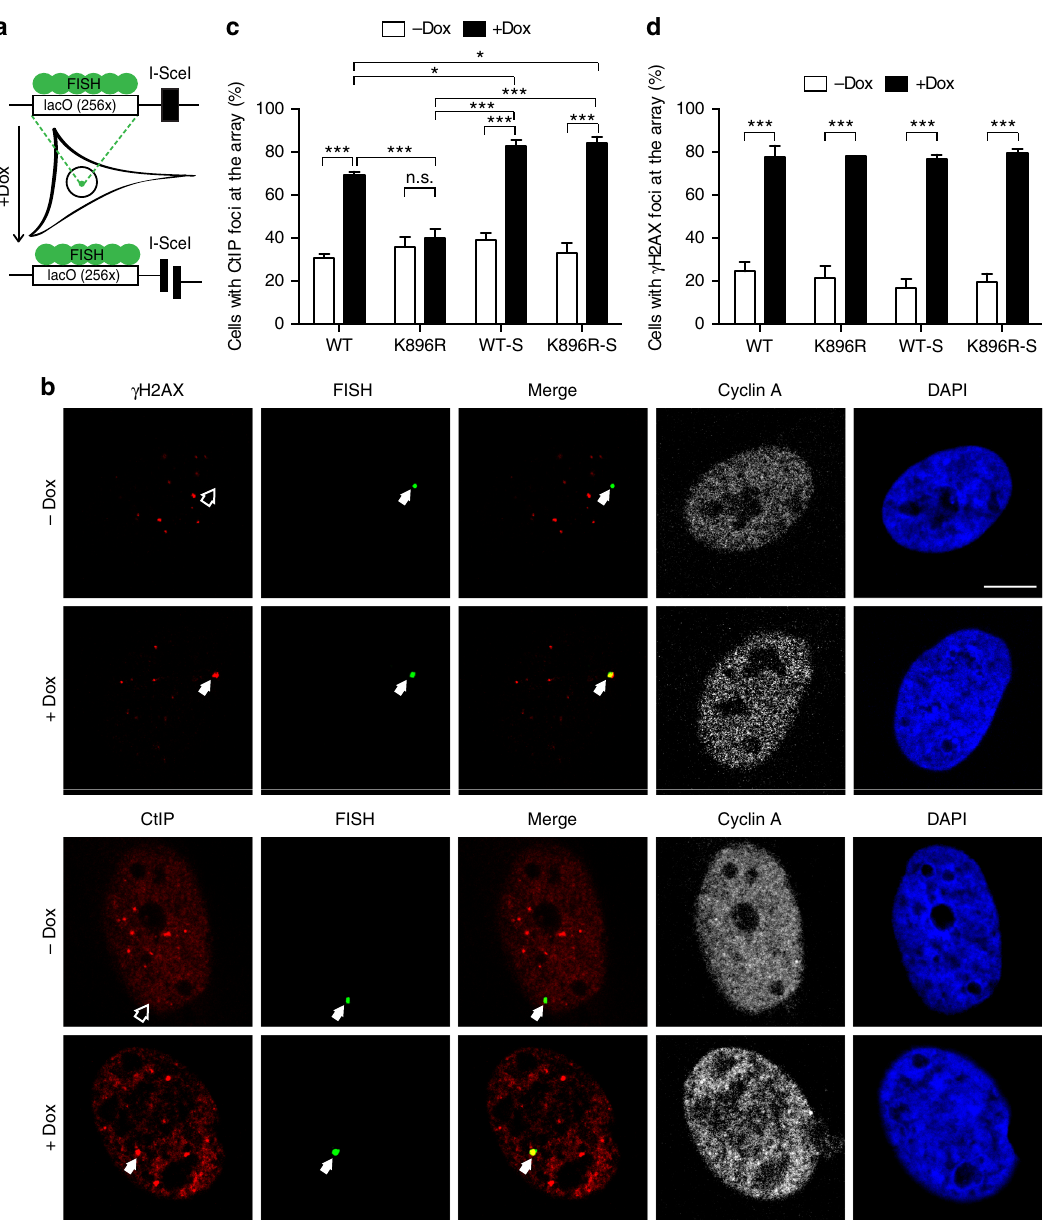
Fig. 6 Sumoylation of CtIP controls its recruitment to DSBs. a Schematic representation of the experimental system to measure protein recruitment to DSBs. b Immuno-FISH representative confocal images of the lacO array in green , cyclin A in white , and γ H2AX ( top ) or CtIP ( bottom ) in red , in U2OS19ptight13 expressing Flag-Cherry-CtIP. Cells were treated with doxycyline (+Dox) to create a DSB or mock treated ( – Dox), as indicated in the Methods section. A white arrow marks the position of the array and the accumulation of either CtIP or γ H2AX upon DSB induction. An empty arrow marks the position of the array when no accumulation of CtIP or γ H2AX can be observed (undamaged conditions, – Dox). The white scale bar represents 7.5 μ M. c Quanti fi cation of the percentage of colocalization of the lacO array with Flag-Cherry-CtIP variants in cells treated as mentioned in b depleted for endogenous CtIP. d Same as c but showing colocalization of the lacO array with γ H2AX. Values in c and d represent the average and SEM of three independent experiments. En each experiment, 50 cells were scored. Two-way ANOVA analysis was performed to compare the indicated conditions in each graph. * P < 0.5; ** P < 0.01; *** P < 0.001. When biologically relevant, not signi fi cant differences are marked as